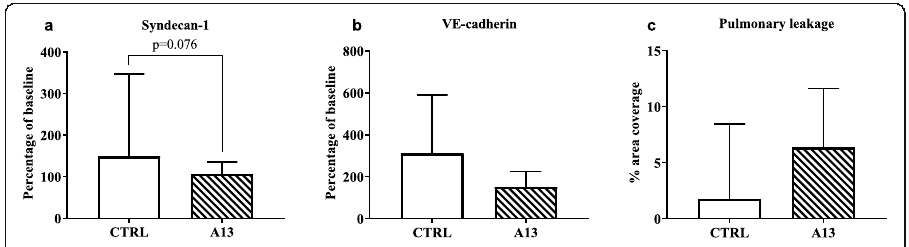
Fig. 4 Endothelial functioning. a Levels of syndecan-1 after sacrifice relative to baseline values. b VE-cadherin after sacrifice relative to baseline values. c Percentage of image covered by dextran-FITC as a reflection of endothelial leakage in the lungs. Data is presented as median and IQR